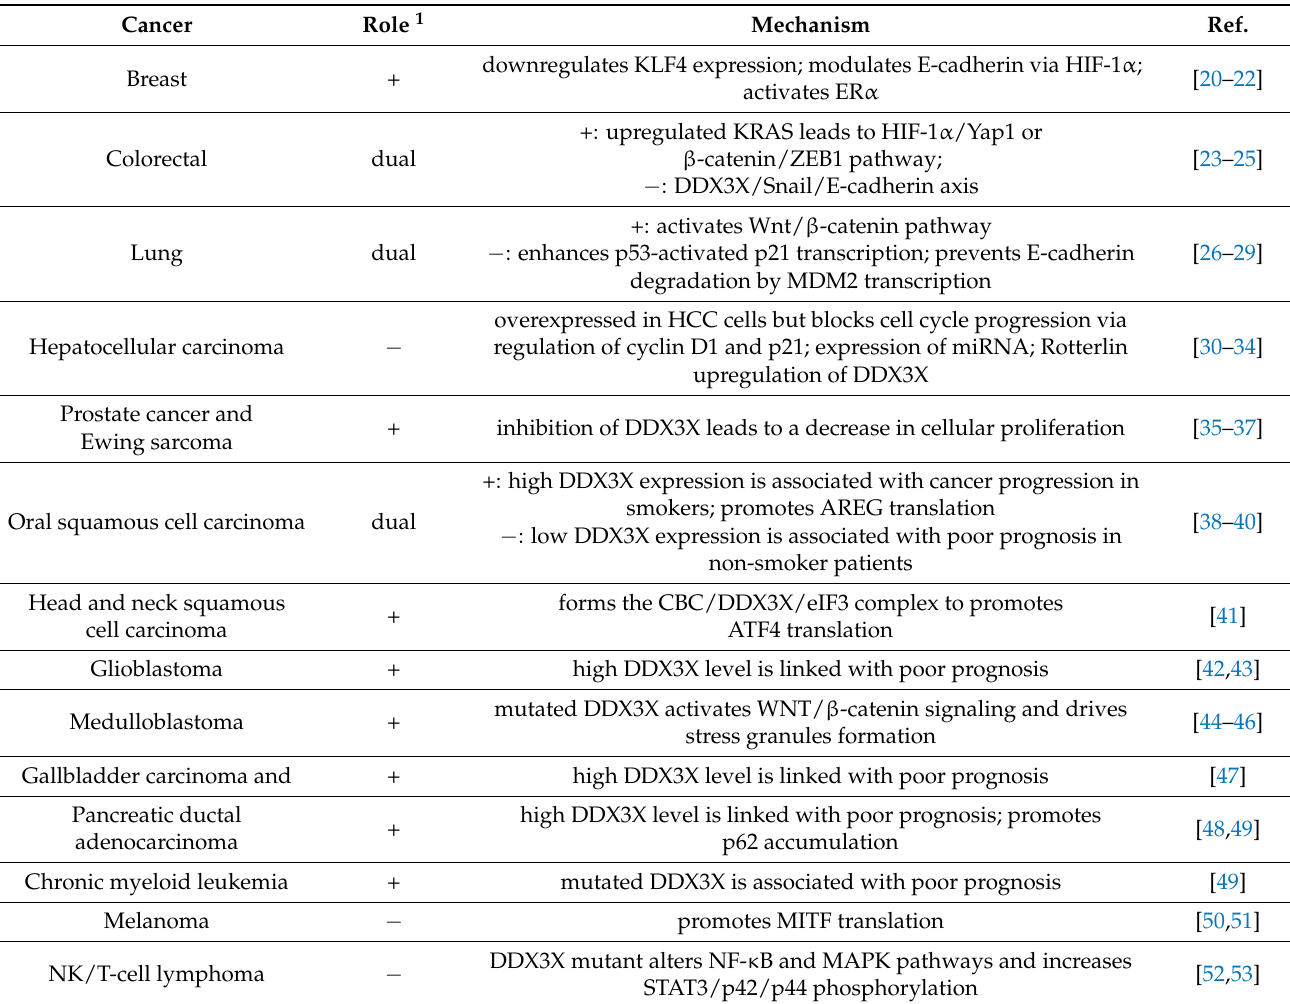
Table 1. Role of DDX3X in